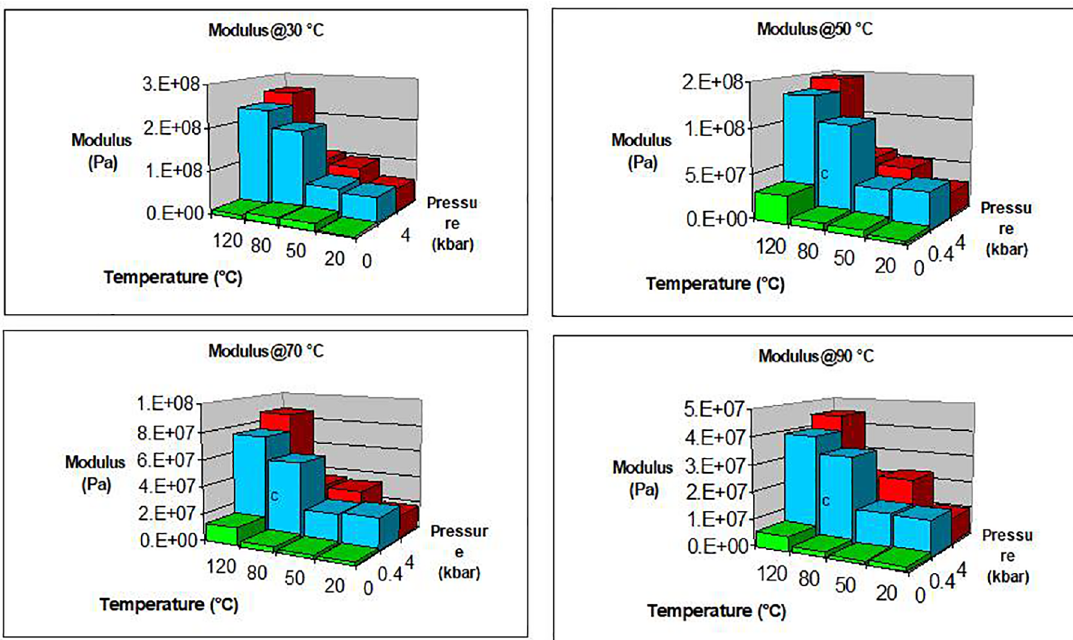
Figure 3. Dependence on hot pressing conditions of the tensile modulus of the PVdF-CTFE 10% membranes measured at selected temperatures (30, 50, 70 and 90 °C).